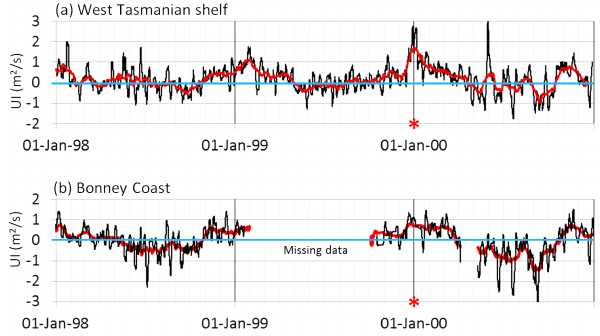
Figure 4. Time series (1 January 1998 to 31 December 2000) of the upwelling index (m 2 s − 1 ) for (a) the western Tasmanian shelf and (b) the Bonney coast. Thin, black (thick, red) curves are 4-day (20- day) moving averages. Stars highlight an upwelling event in early January 2000, corresponding to the spatial distributions shown in Fig. 3. Data source: Bureau of Meteorology,